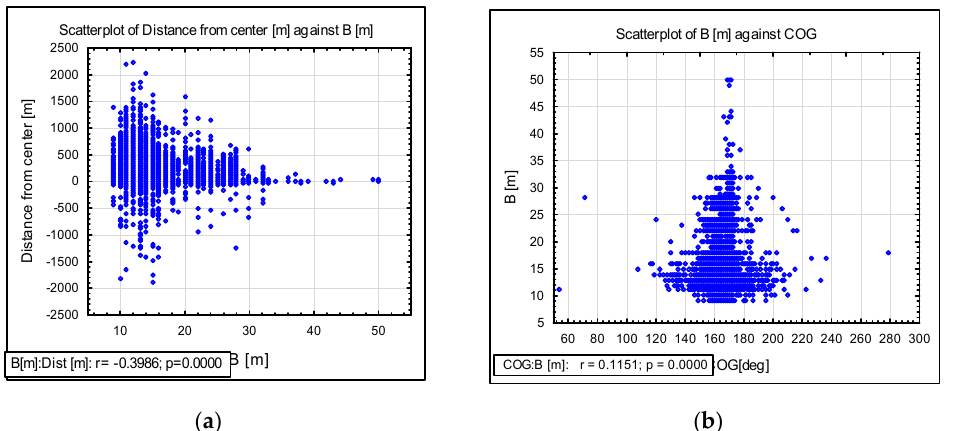
Figure 13. ( a ) Scatterplot of distance from centre versus draught T . ( b ) Scatterplot of a vessel’s width versus COG.